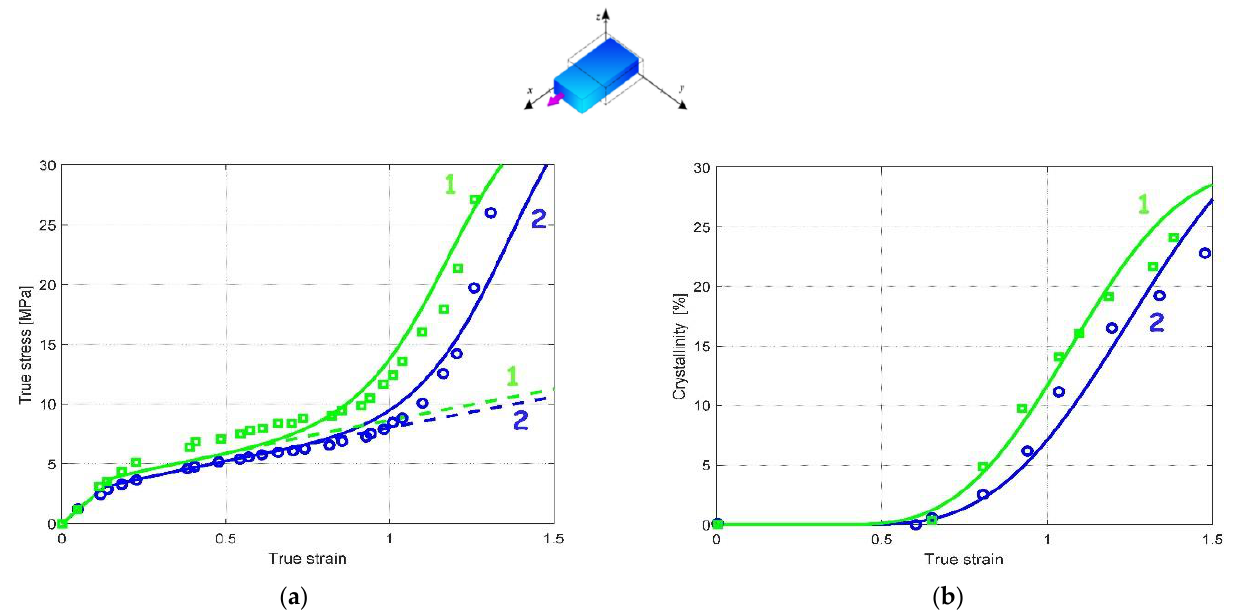
Figure 3. Model results under UA loading at a loading temperature of 90 ◦ C and different strain rates (1: 2.1/s, 2: 0.42/s): ( a ) stress–strain response, ( b ) strain-induced crystallization; solid lines: model; dashed lines: model with no crystallization; symbols: experimental data of Salem